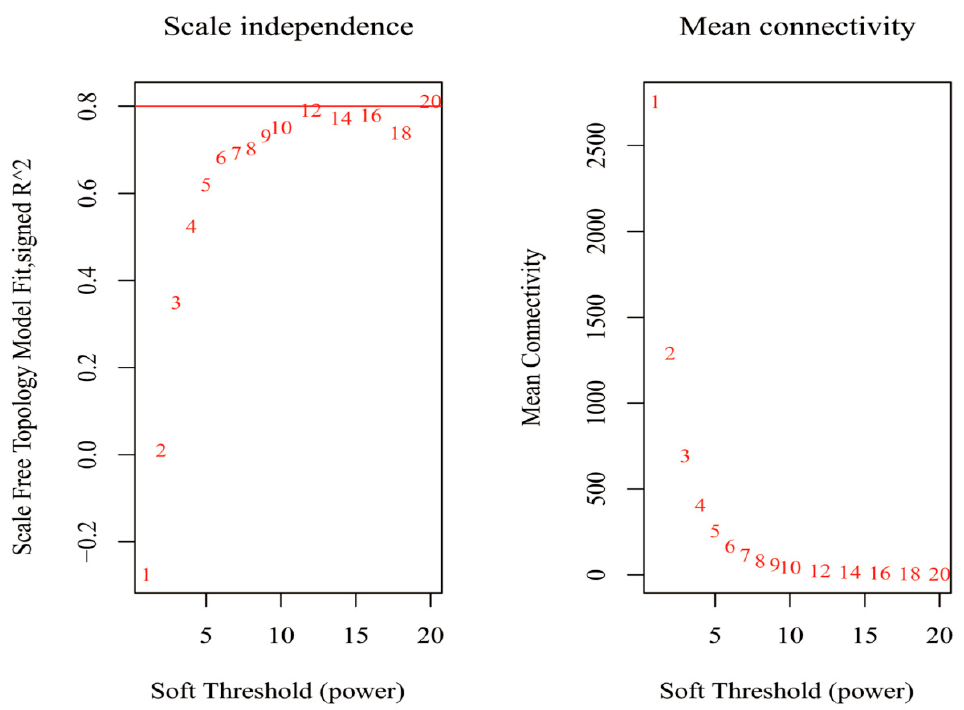
Figure 5. Determination of the soft threshold power of GSE102134. Scale-free fit index for various soft threshold powers ( β ) with the signed R 2 (Y) and the soft threshold power (X). Mean connectivity (Y) for various soft powers, which is a strictly decreasing function of the power β (X).